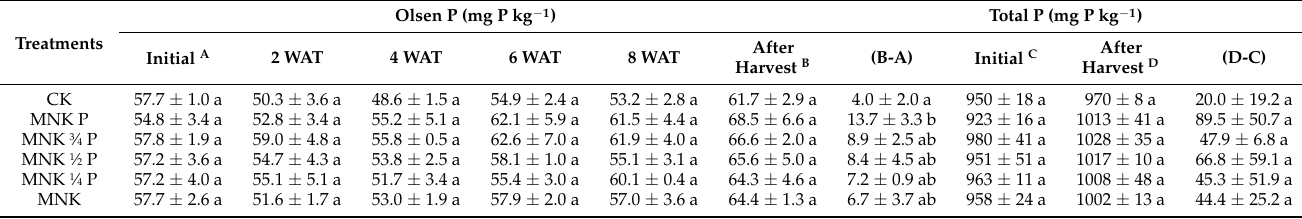
Values are means ( n = 3) ± standard deviations. Mean followed by different letters within a column indicates significant difference using the Tukey–Kramer test ( p < 0.05). (B-A) is the increase in soil Olsen P after one cropping season among treatments. (D-C) is the increase in soil total P after one cropping season among treatments.